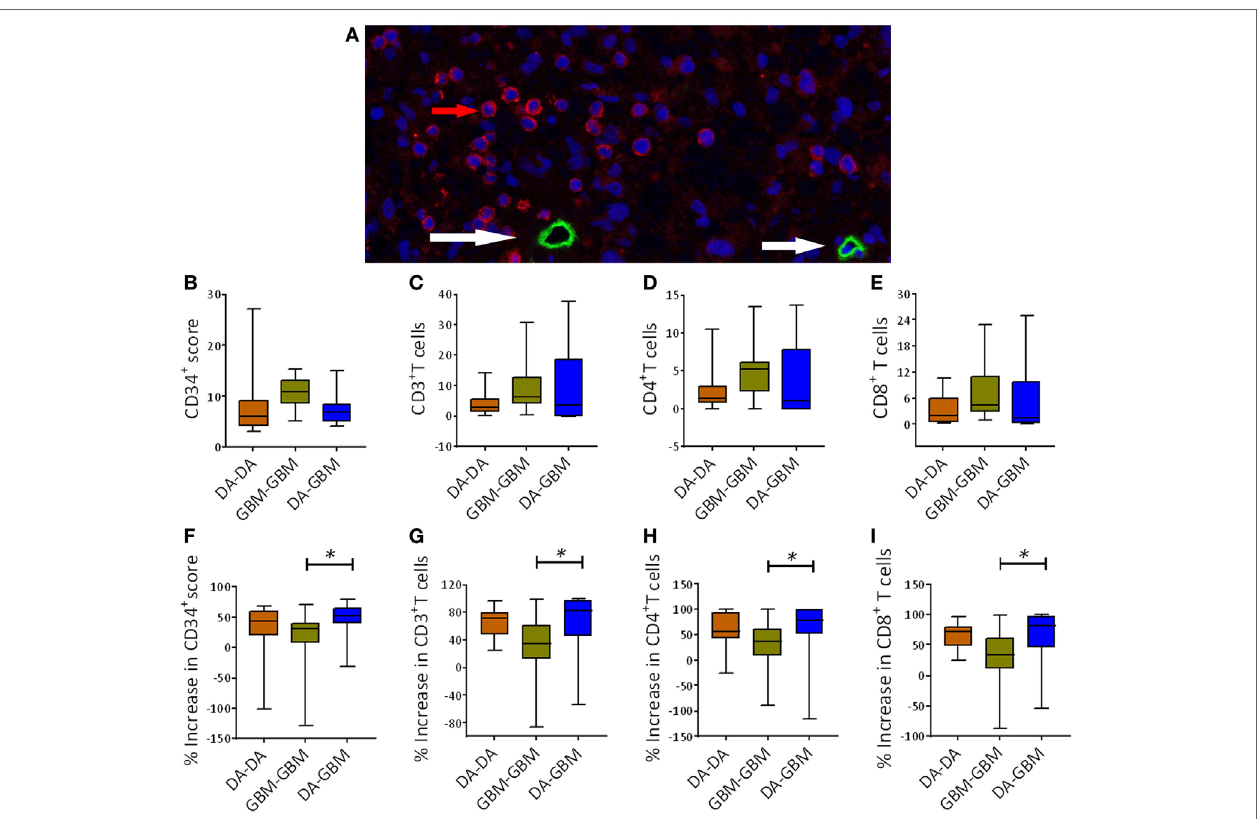
FigUre 1 | A similar kinetic movement of tumor angiogenesis and T cell infiltrations upon tumor recurrence [e.g., diffuse astrocytomas (DA)–DA, 15 pairs, DA–GBM, 15 pairs and GBM-GBM, 14 pairs]. (a) A representative fluorescent immunohistochemistry staining of tumor blood vessels measured by CD34 staining (green, red arrow) and tumor-infiltrating CD3 + T cells (red, white arrow) in a surgical resected primary GBM sample. (B–e) The baseline counts of CD34 + circles, CD3 + , CD4 + , and CD8 + cells in tumors. Counts were carried out for average numbers [10 consecutive high powered fields (HPFs)] of these marker expressing cells in primary tumors among three groups. (F) Enhancement of CD34 + circles after the recurrence. A calculation was carried out by comparing the increase in CD34 + circles between recurrent and primary tumors. (g–i) A similar measurement was also carried out for the average numbers of infiltrating CD3 + , CD4 + , and CD8 + T cells in these patients’ tumors, respectively. The significance between two groups was measured using Mann–Whitney U test, * p <